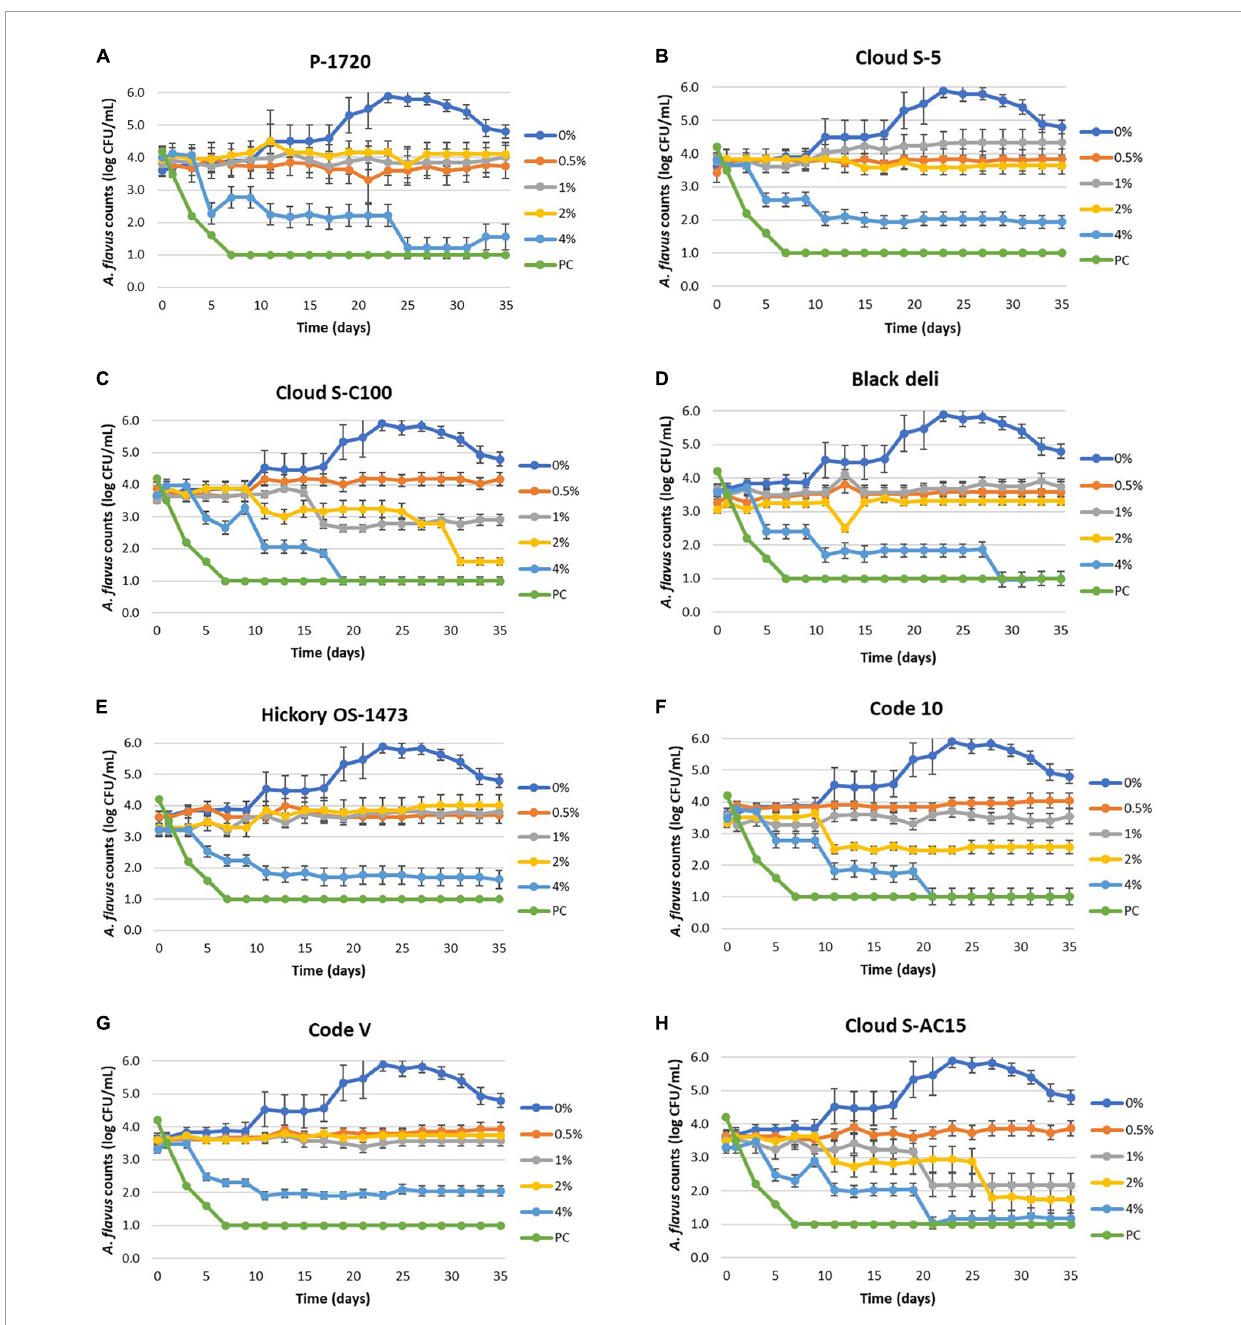
FIGURE1 (A–H) Mean logarithmic counts (log CFU/mL) of Aspergillus flavus in semi-moist pet food treatments with inclusion of liquid smoke preparations P-1720 (A) , Cloud S-5 (B) , Cloud SC-100 (C) , Black deli (D) , Hickory OS-1473 (E) , Code 10 (F) , Code V (G) , and Cloud S-AC15 (H) at 0.5, 1, 2, and 4% concentrations in comparison with untreated (0% smoke). Potassium sorbate treatment (PC, positive control) did not show mold growth during the 35-day period. The detection limit is 1.0 log CFU/mL for sampling using PDA